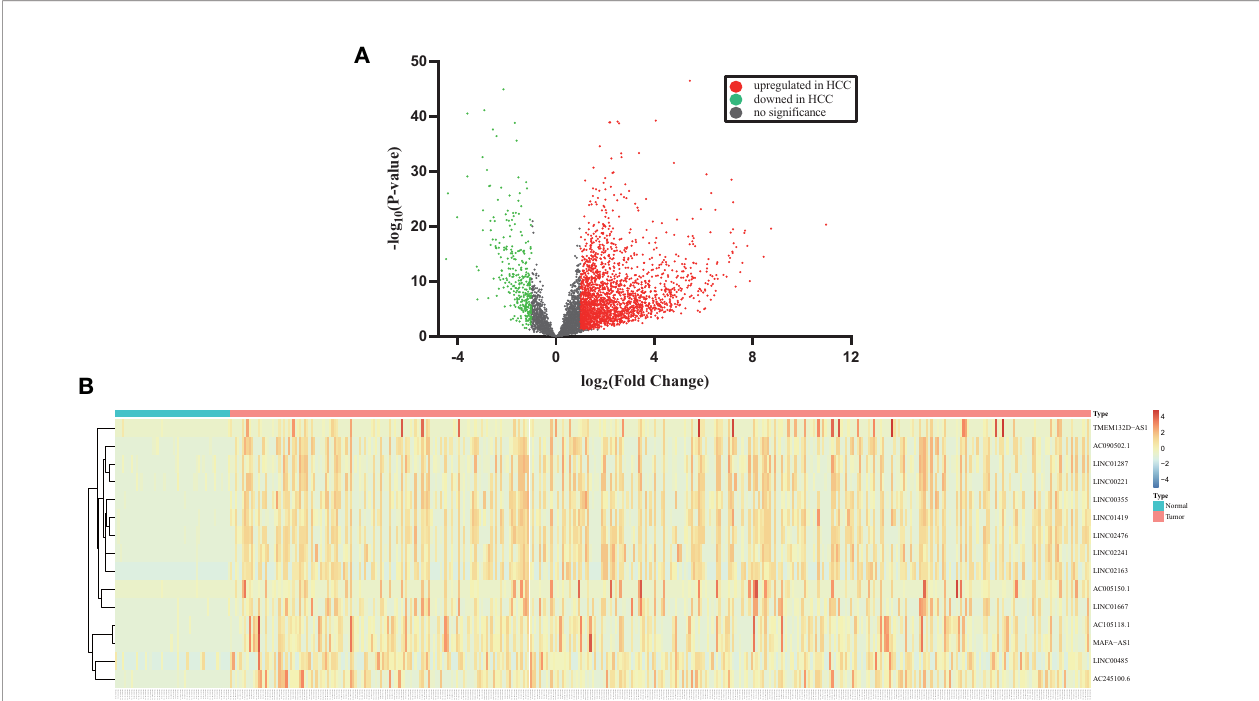
FIGURE 2 | Identi fi cation of differentially expressed lncRNAs in HCC from TCGA. (A) Volcano plot displays the changes of lncRNA expression pro fi les in the TCGA. Each dot represents a lncRNA. Red and green dots indicate upregulated and downregulated lncRNAs, respectively. (B) Heatmap shows the detailed expression patterns of fi fteen dysregulated lncRNAs in TCGA samples. Each colored block at different position re fl ects the relative expression of corresponding lncRNA in relevant sample. Red indicates high expression and blue indicates low